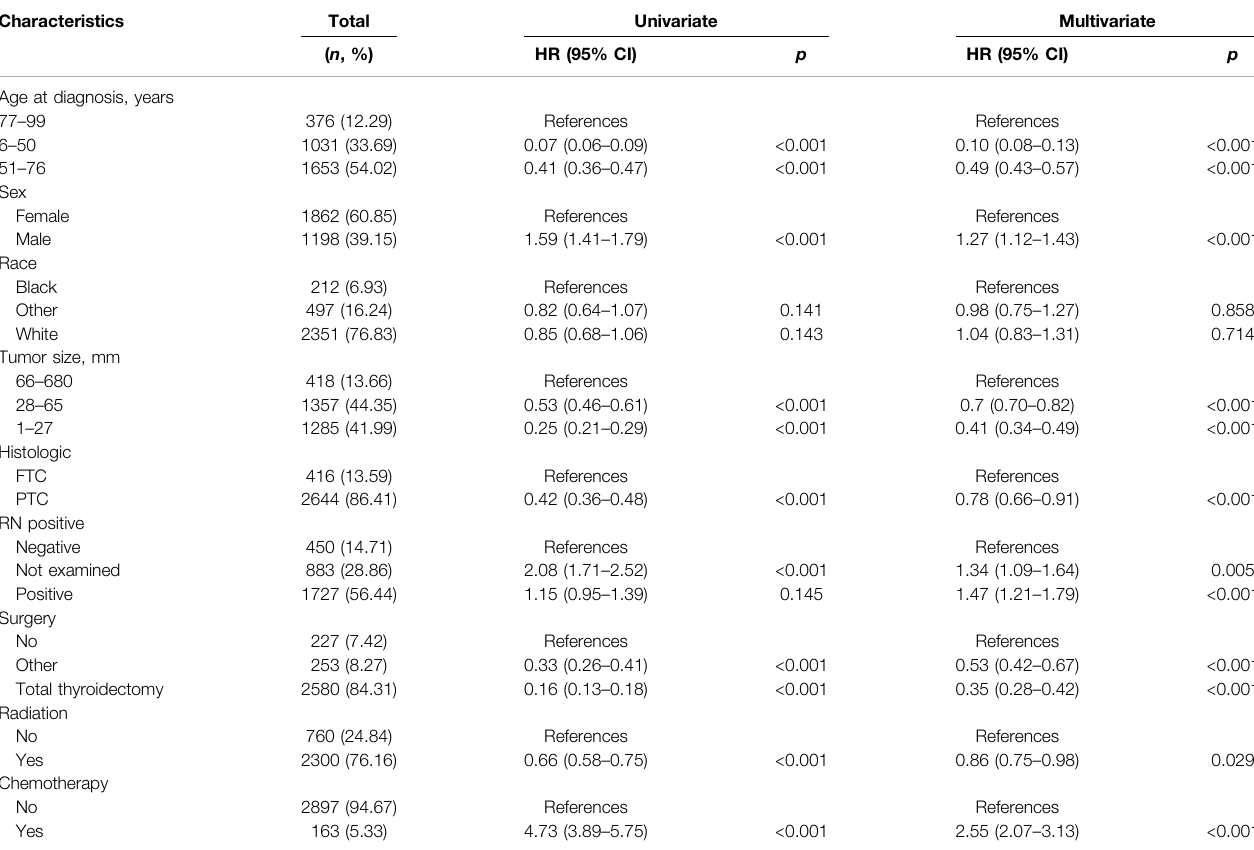
TABLE 1 | The baseline characteristics, univariate and multivariate cox